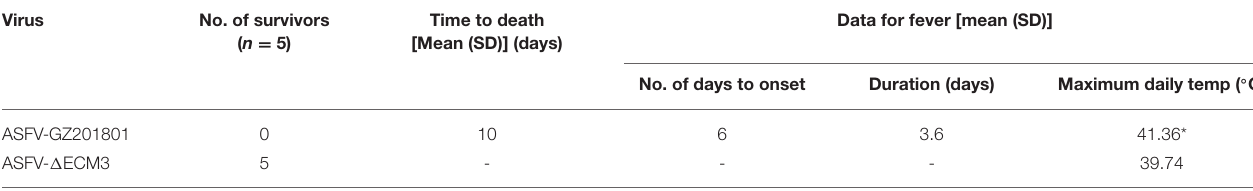
TABLE 2 | Swine survival and fever response following infection with ASFV- 1 ECM3 and challenge with parental GZ201801. Virus